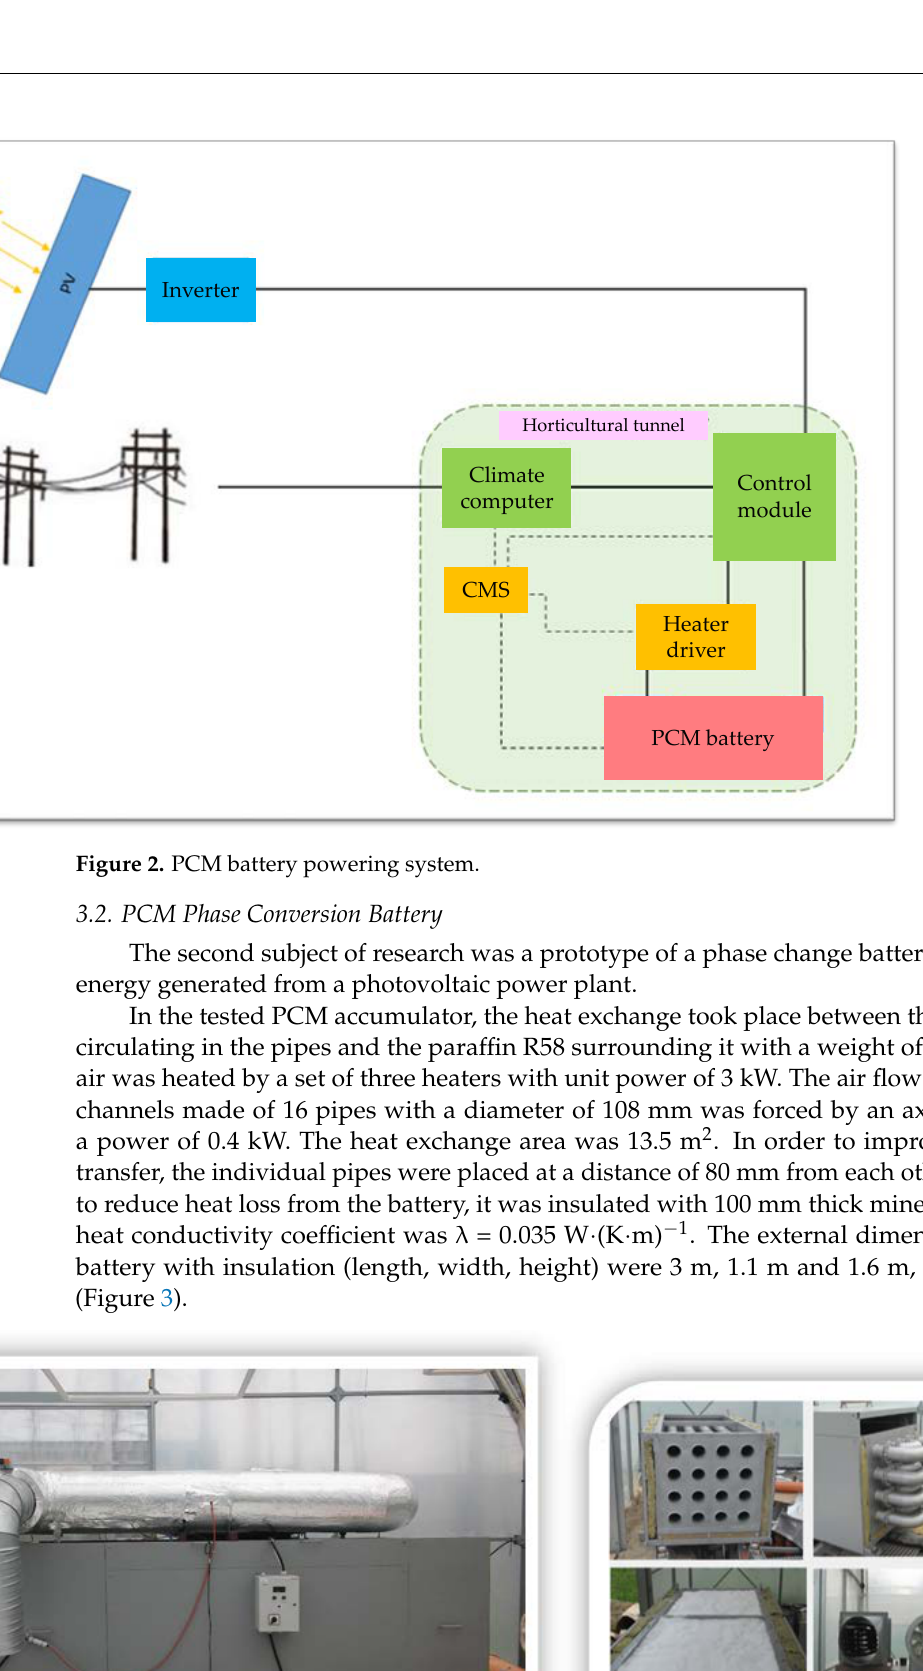
Figure 2. PCM battery powering system.